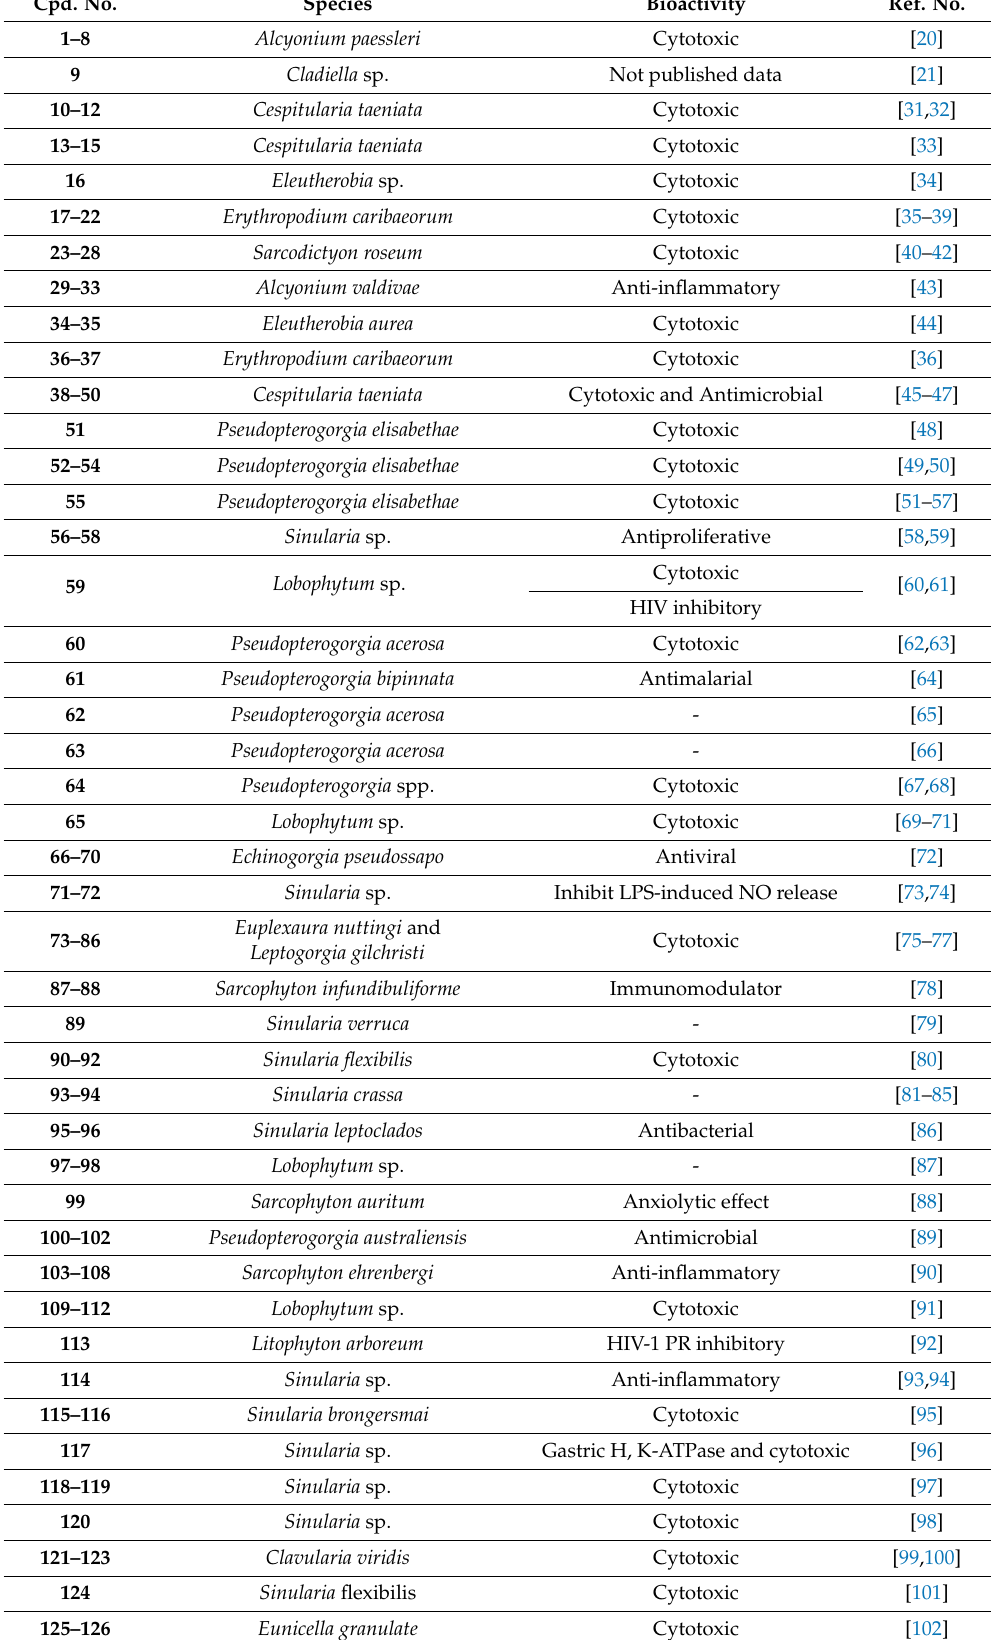
Table 1. Bioactivity of nitrogen containing metabolites from